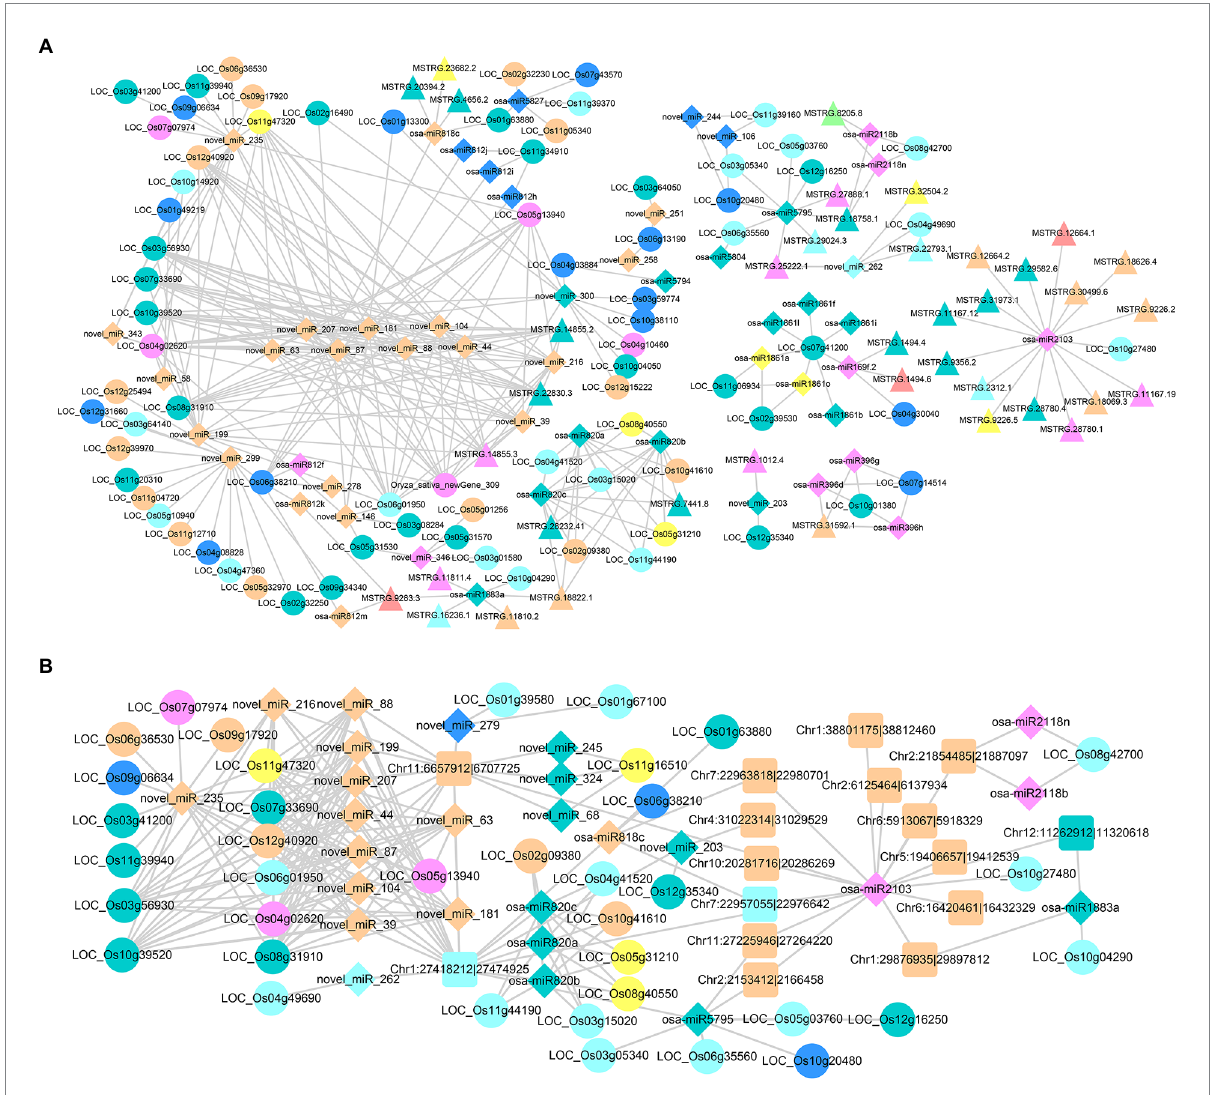
FIGURE 8 Regulatory networks of DEmiRNAHPs and ceRNAs. (A) Regulatory network of DElncRNAHPs as ceRNA. (B) Regulatory network of DEcircRNAHPs as ceRNA. The target DEGHPs, DElncRNAHPs, DEmiRNAHPs and DEcircRNAHPs were represented by circle, triangle, diamond and square, respectively. The colors of the different types of RNA were consistent with those illustrated in Supplementary Figure